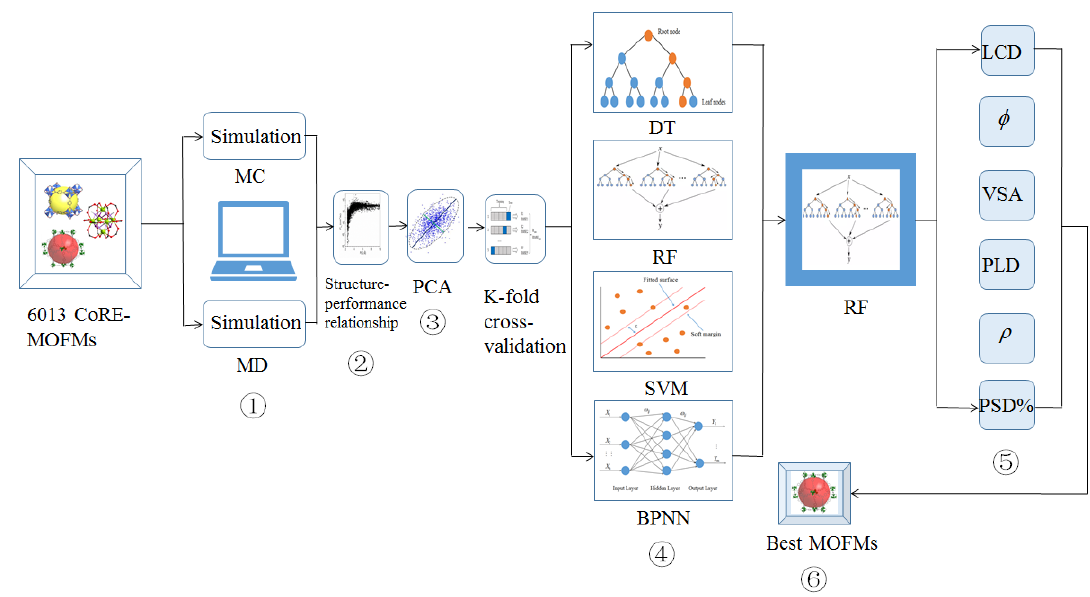
Figure 1. Schematic diagram of the project framework.